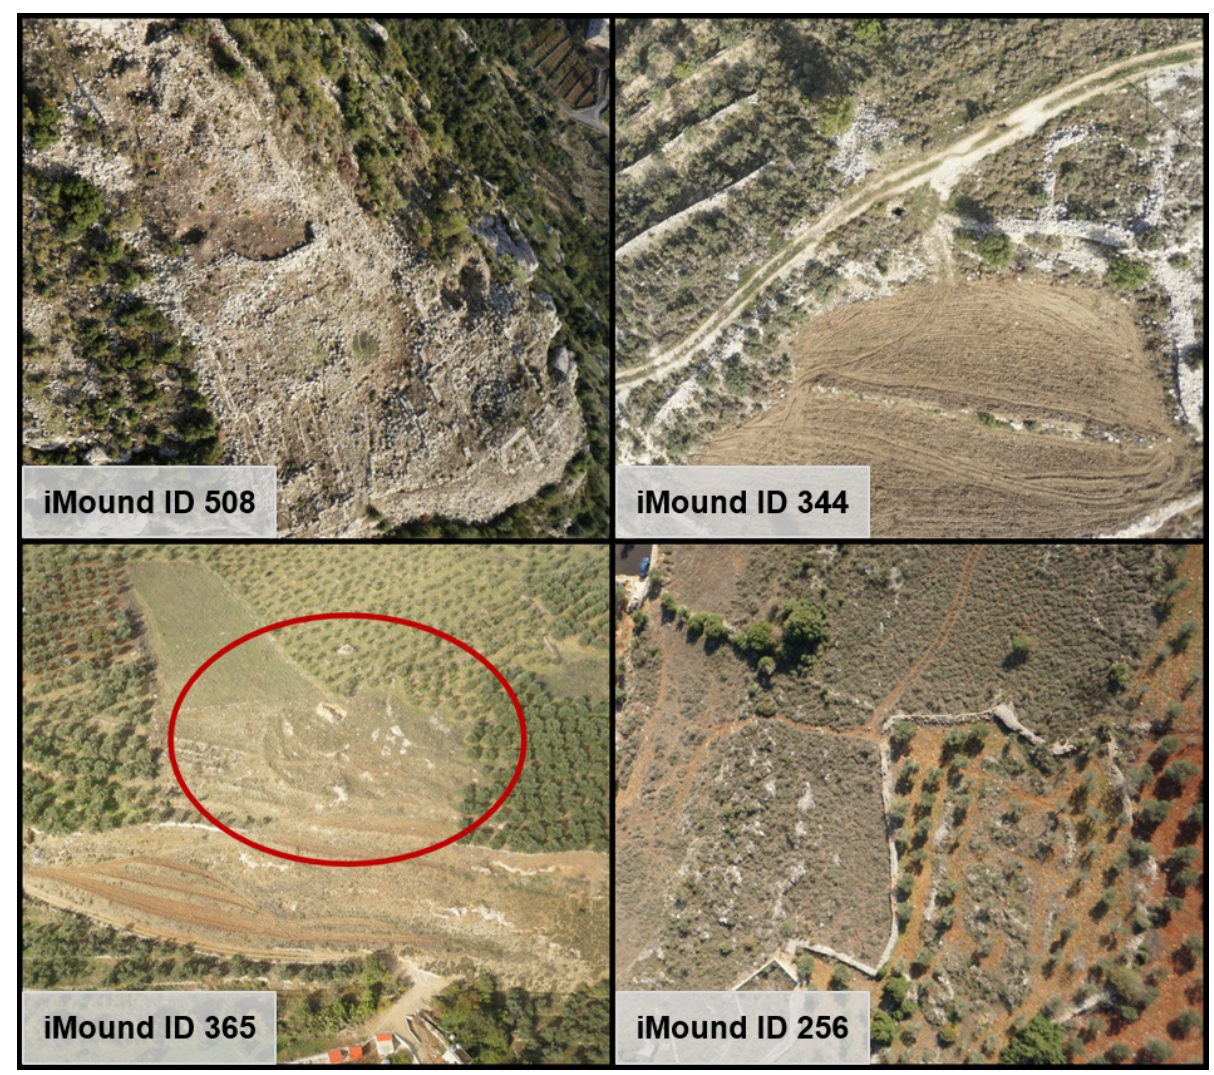
Figure 11: Aerial images showing four iMounds with high scores. Top left: Clear settlement structures of iMound 508. Top right: Round wall structures of iMound 344. Bottom left: Vegetated structures of iMound 365, encircled in red. Bottom right: Wall structures and old terraces of iMound